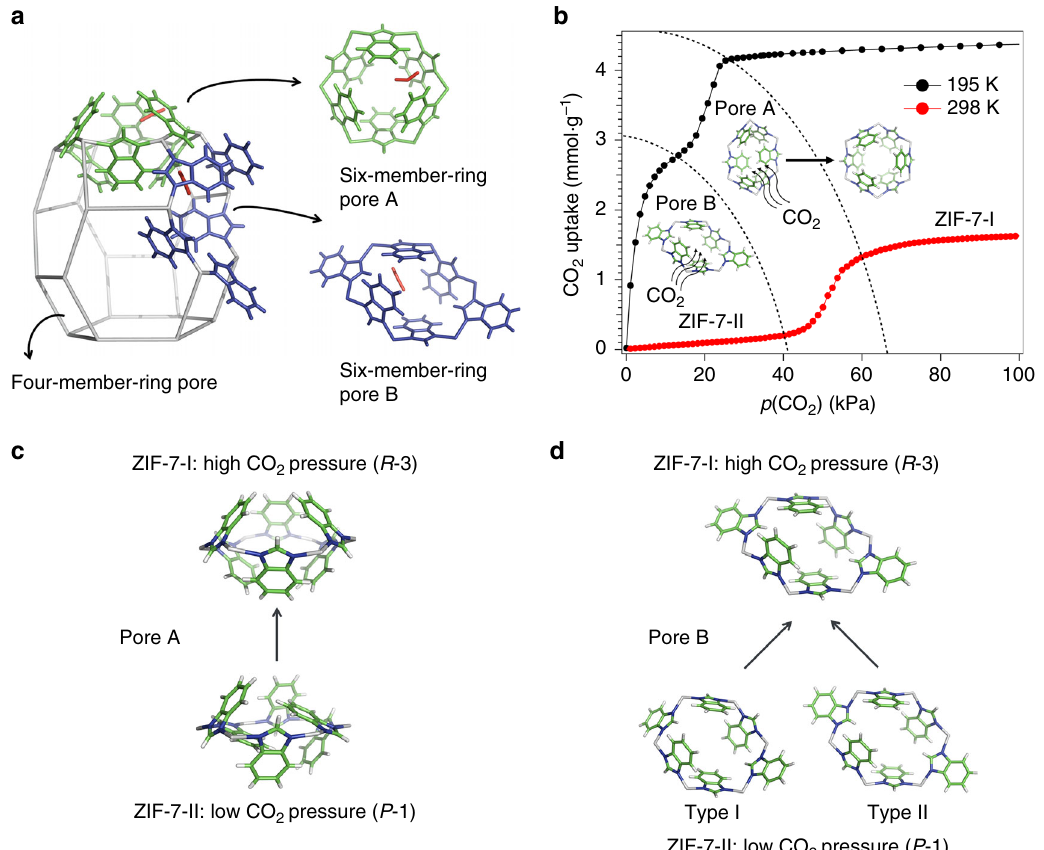
Fig. 1 ZIF-7 structure and its CO 2 adsorption behavior. a The building unit, sodalite cage, of ZIF-7 with two types of six-member-ring pores (A, B) and one type of four-member-ring pores on its walls. Part of the framework is simpli fi ed by replacing Zn − bIm − Zn with Zn − Zn (bIm = benzimidazolate, C 7 N 2 H 5 , Zn: gray). In our previous work 18 , we have demonstrated CO 2 molecules prefer to be adsorbed in six-member-ring pores, as shown here. In addition, there are more CO 2 molecules adsorbed in pore B than in pore A. CO 2 : red. The symmetry of CO 2 has been disregarded for clarity. b CO 2 adsorption isotherms of ZIF-7 at 195 and 298 K, p CO2 = 1 – 100 kPa, illustrated by the structural behaviors of ZIF-7. c The structural change of pore A in the ZIF-7-II to ZIF-7-I phase transition. Zn: gray; N: blue; C: green; H: white. d The structural change of pore B in the ZIF-7-II to ZIF-7-I phase transition. Zn: gray; N: blue; C: green; H: white. See the crystal structures of ZIF-7-I and ZIF-7-II in Supplementary Fig. 2 and Supplementary Table